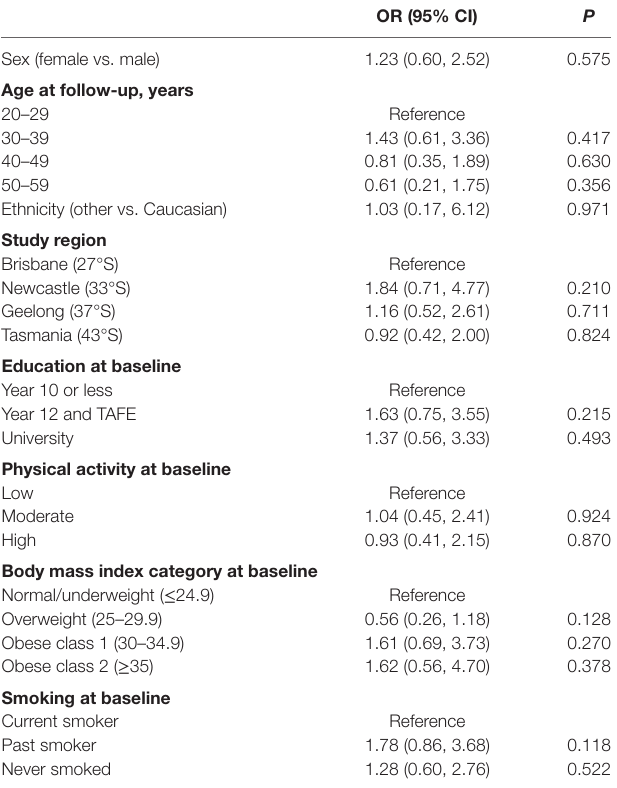
TaBle 3 | A multivariable logistic regression model a showing independent associations between participant characteristics and odds of making a dietary change ( n = 221